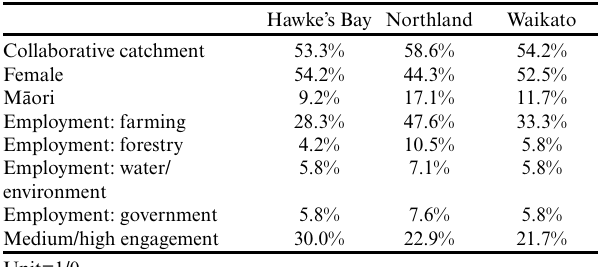
Table 1 . Summary